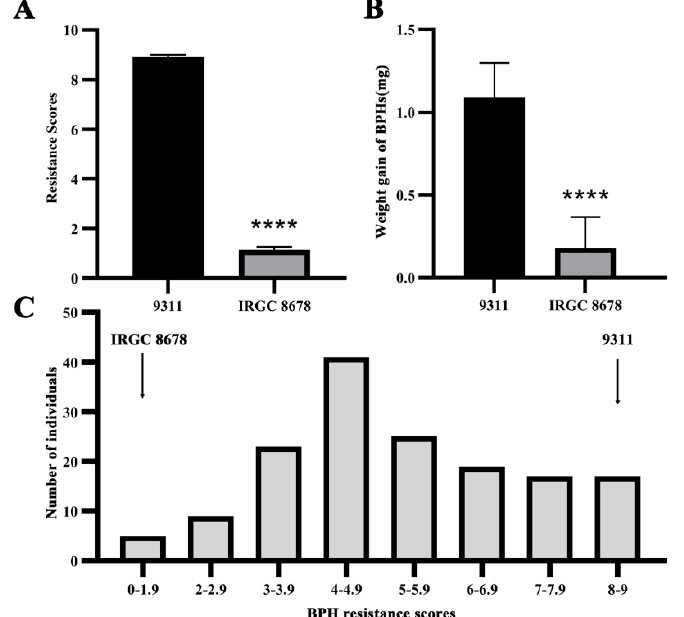
Figure 1. Genetic analysis of brown planthopper (BPH) resistance in IRGC 8678. ( A ) BPH resistance scores of 9311 and IRGC 8678; ( B ) weight gains of BPHs fed on 9311 and IRGC 8678 for 48 h. All data are means ± the standard error of the mean (SEM). **** indicates a significant difference at p < 0.0001 by t-test; ( C ) frequency distributions of the BPH resistance scores in the F 2 population derived from 9311 × IRGC 8678.